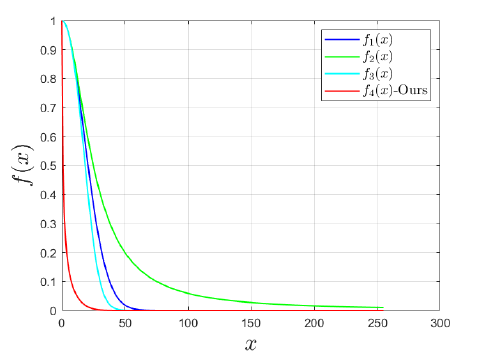
Figure 3. Comparisons of different diffusion coefficient function